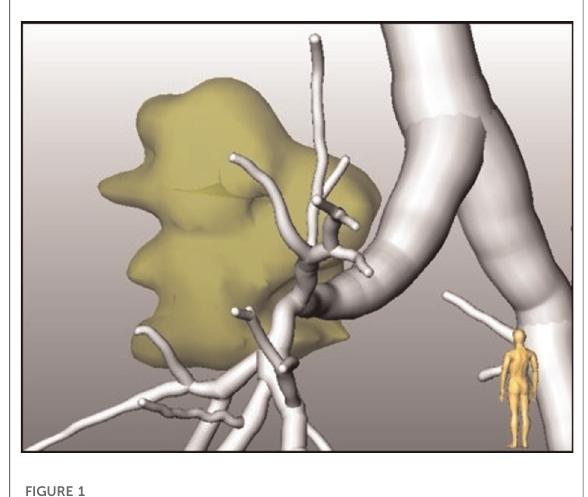
FIGURE 1 CT-based segmentation of a tumor in relation to the bronchial